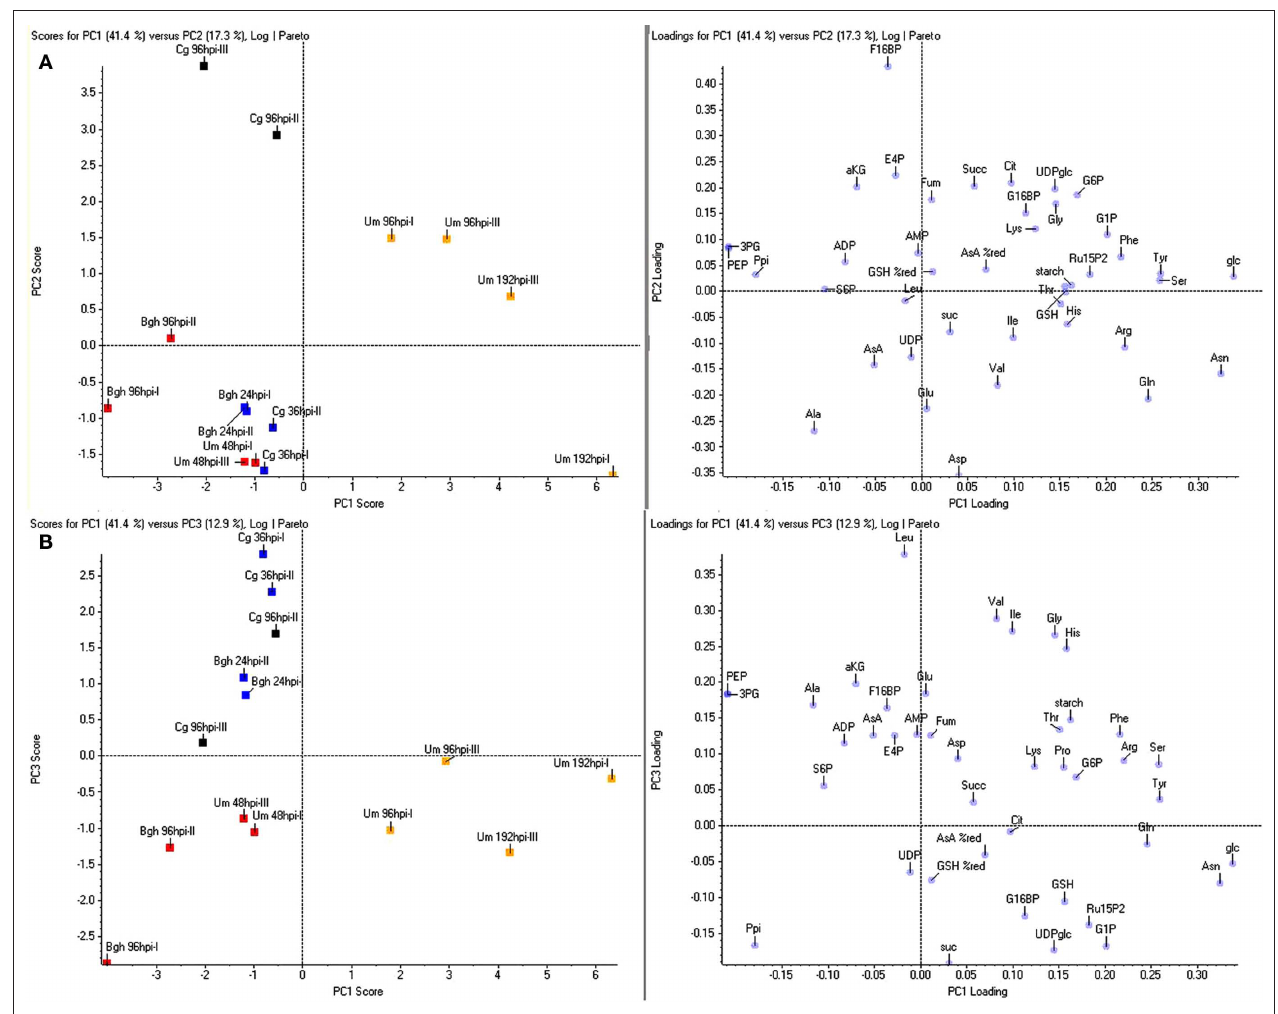
(ascorbate); %AsA red, (% reduced ascorbate); Cit, (citrate); E4P, (erythrose-4- phosphate); F16BP, (fructose-1,6-bisphosphate); F6P, (fructose-6-phosphate); frc, (fructose); Fum, (fumarate); G16BP, (glucose-1,6-bisphosphate); G1P, (glucose-1- phosphate); G6P, (glucose-6-phosphate); glc, (glucose); GSH, (glutathione); %GSH red, (% glutathione reduced); Icit, (isocitrate); PEP, (phospho enol pyruvate); 3PG, (3-phosphoglycerate); 6PG, (6-phosphogluconate); Ppi, (pyrophosphate); Pyr, (pyruvate); RubP, (ribulose-1,5-bisphosphate); S6P, (sucrose-6-phosphate); suc, (sucrose); Succ, (succinate); T6P, (trehalose-6- phosphate);